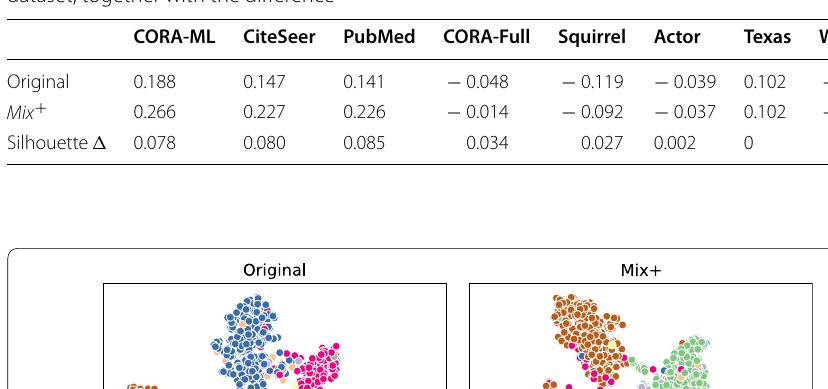
Table 3 Average silhouette coefficient for original and Mix + graphs. After training a GCN model on each graph (initializing the weights 10 times), we calculate the average silhouette coefficient of the intermediate representation in the first GCN layer. We report the mean of these values over each dataset, together with the difference